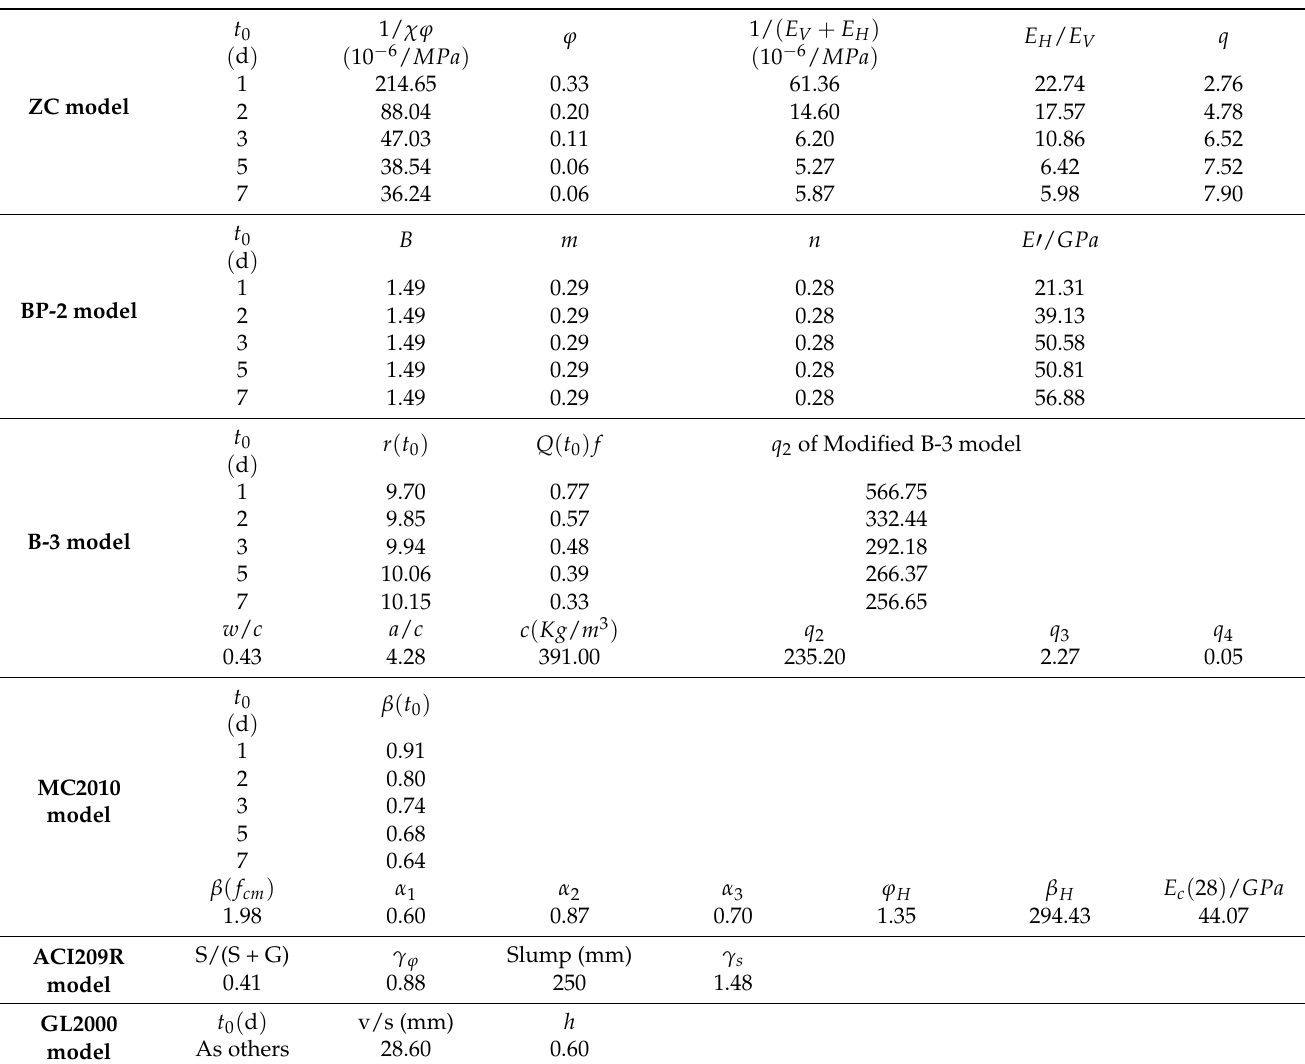
Table 5. Calculated values of parameters in different prediction